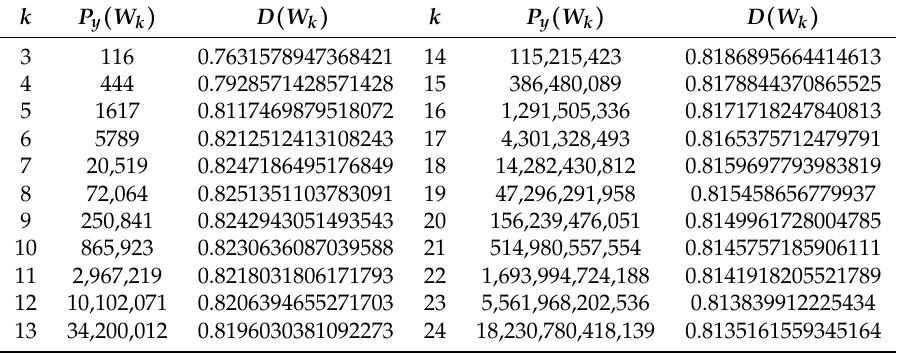
Table 3. Related data for wheel graph W n ( n = 3,4 . . . ,24 )